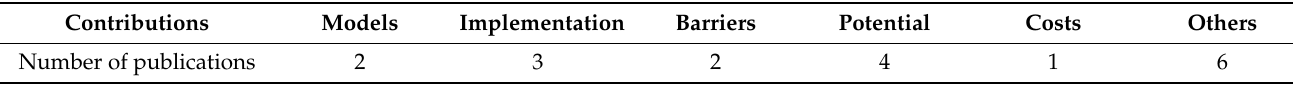
Table 6. Trend of research on demand response in other regions.